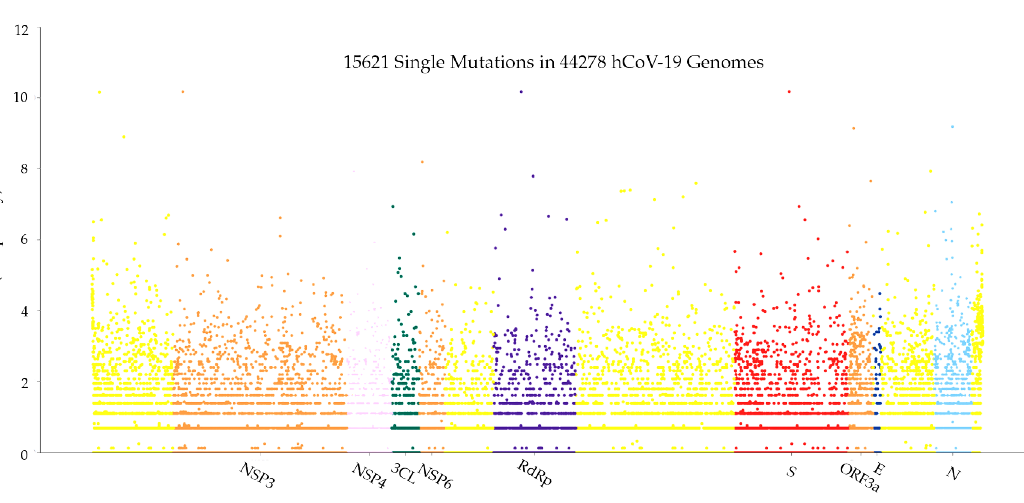
Figure 13. Genome-wide SARS-CoV-2 mutation distribution. The y -axis represents the natural log frequency for each mutation on a specific position of the complete SARS-CoV-2 genome. While only a few landmark positions are labeled with gene (protein) names, the relative positions of other genes (proteins) can be inferred from Table